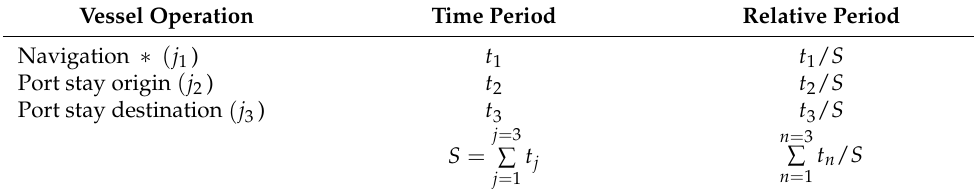
Table 1. Operation distribution of a single vessel. Vessel Operation Time Period Relative